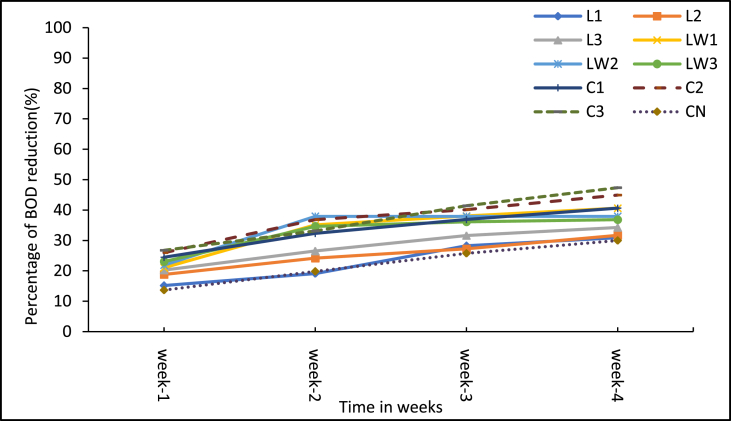
Cumulative mean reduction in BOD5 levels. Note: L1 = 25 mL stock LSEC, L2 = 50 mL stock LSEC, L3 = 75 mL stock LSEC, LW1 = 0.1% DF, LW2 = 0.5% DF, LW3 = 1% DF, C1 = 5 g calcium carbide, C2 = 8 g calcium carbide, C3 = 10 g calcium carbide, CN = control.